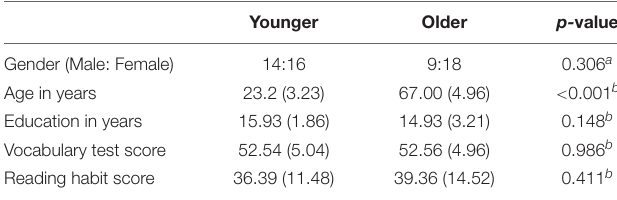
TABLE 1 | Basic demographics and reading skills of younger and older participants (Standard deviations in